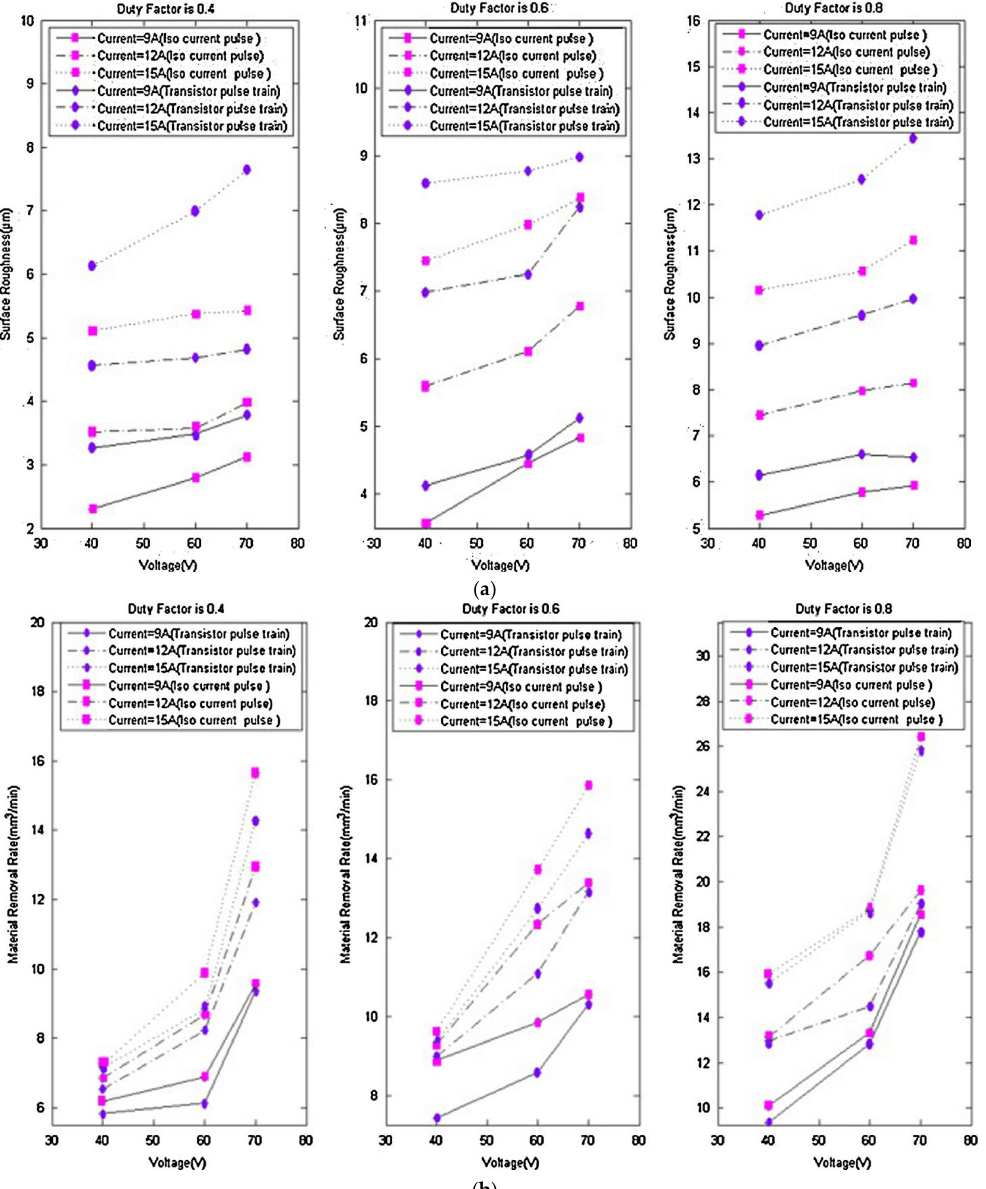
Figure 7. ( a ) Effect of pulse generators on the material removal rate; and ( b ) effect of pulse generators on SR [188].